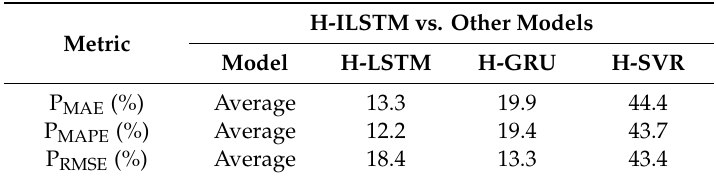
Table 11. The promoting percentages of the other models by the H-ILSTM model of the two-step prediction for the load datasets 1–4.